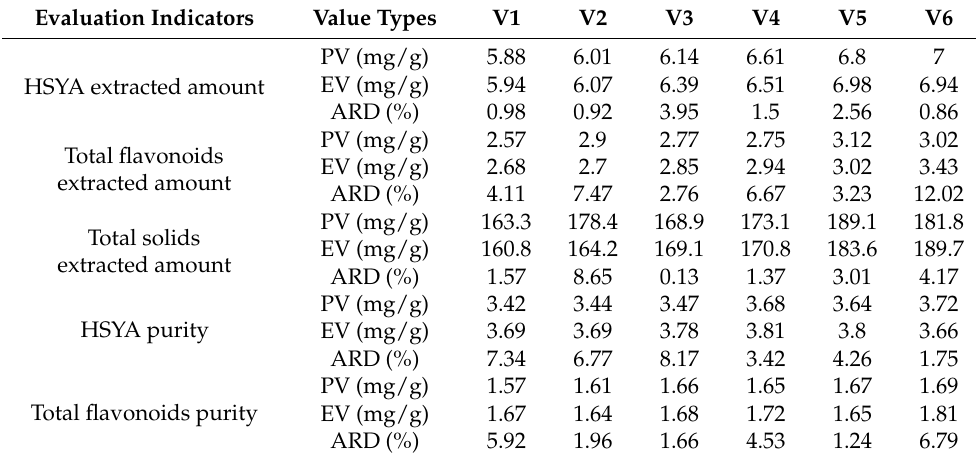
Table 3. The evaluation indicator results of the verification